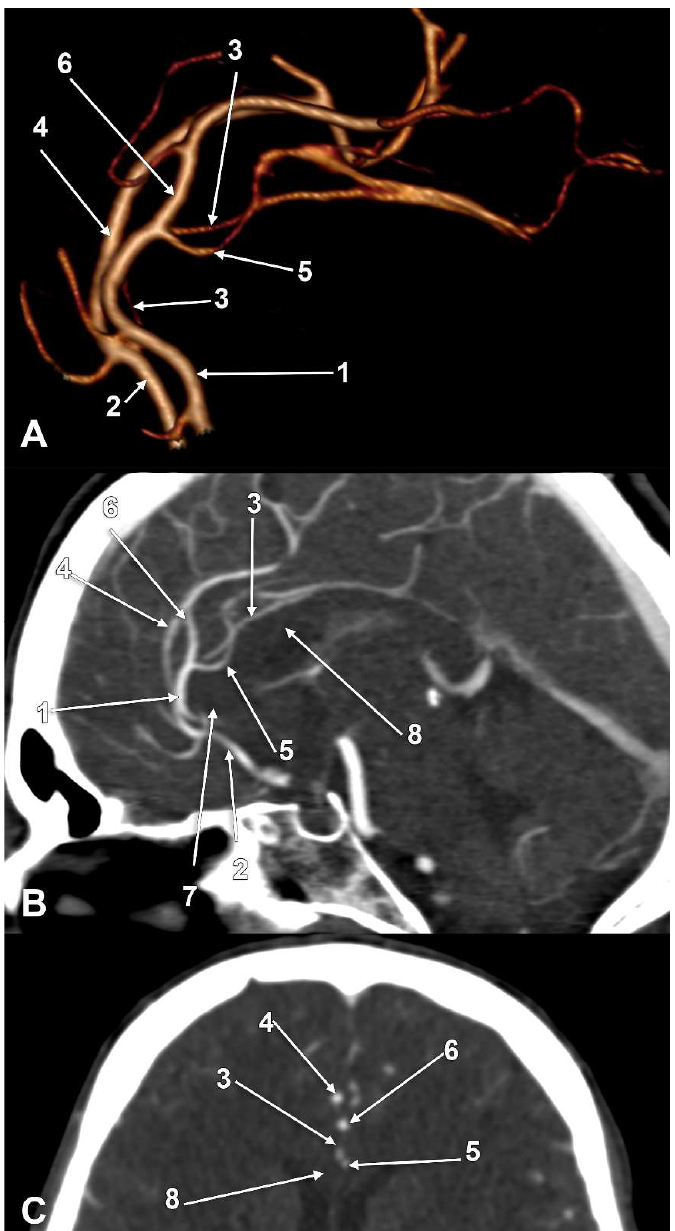
Figure 2. Type 4, pericallosal artery coursing through the corpus callosum. ( A ) Three-dimensional volume rendering, left lateral view; ( B ) Mediosagittal slice through the corpus callosum. ( C ) Axial slice through the corpus callosum: 1. anterior cerebral arteries; 2. left callosomarginal artery; 3. transcallosal course of the left pericallosal artery; 4. right pericallosal artery; 5. genu of corpus callosum; 6. body of corpus callosum.